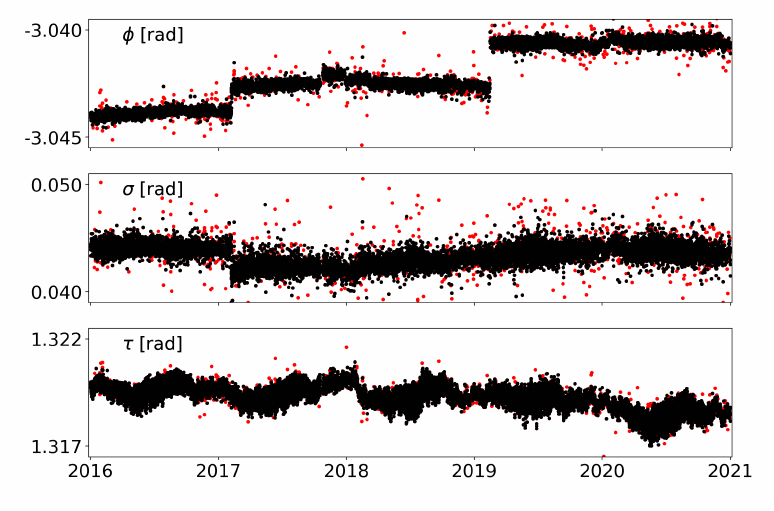
Figure 10. The time evolution of the eulerian angles obtained through automatic calibration for BCN2 with n p = 4, f C = 5pixels and K C = 4. Black dots further satisfy f C = 2pixels and K C =